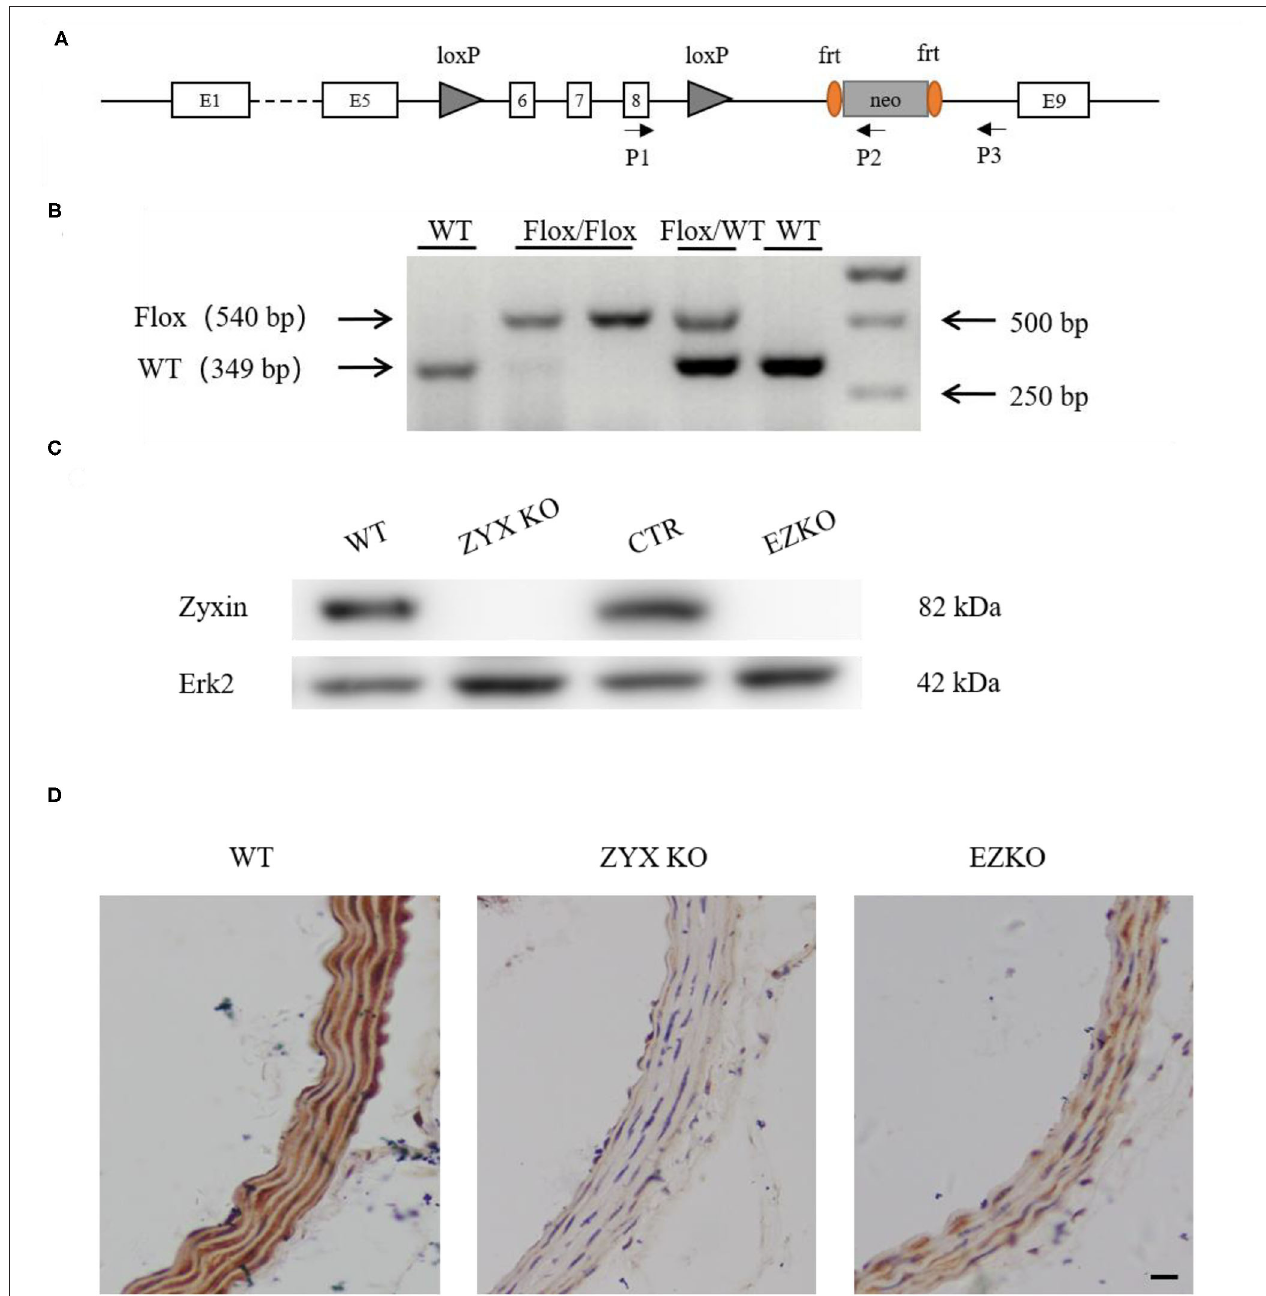
FIGURE 3 | Generation of endothelium-specific zyxin knockout mice. (A) Construction strategy for the Zyx flox / flox mice. Loxp sites are inserted in the introns after exons 5 and 8 of zyxin. (B) Results of genotyping PCR, floxed for 540 bp, WT for 349 bp. (C) Western blots of protein levels of zyxin and Erk2 in WT, ZYX KO, CTR, and EZKO mouse brain vascular endothelial cells. (D) IHC staining of zyxin in the WT, ZYX KO, and EZKO mice (scale bar, 10 µ m). WT, wild-type; ZYX KO, zyxin knockout; CTR, control; Zyx flox / flox ; Tie 2-Cre/ -; EZKO, endothelium-specific zyxin knockout, Zyx flox / flox ; Tie 2-Cre/ +